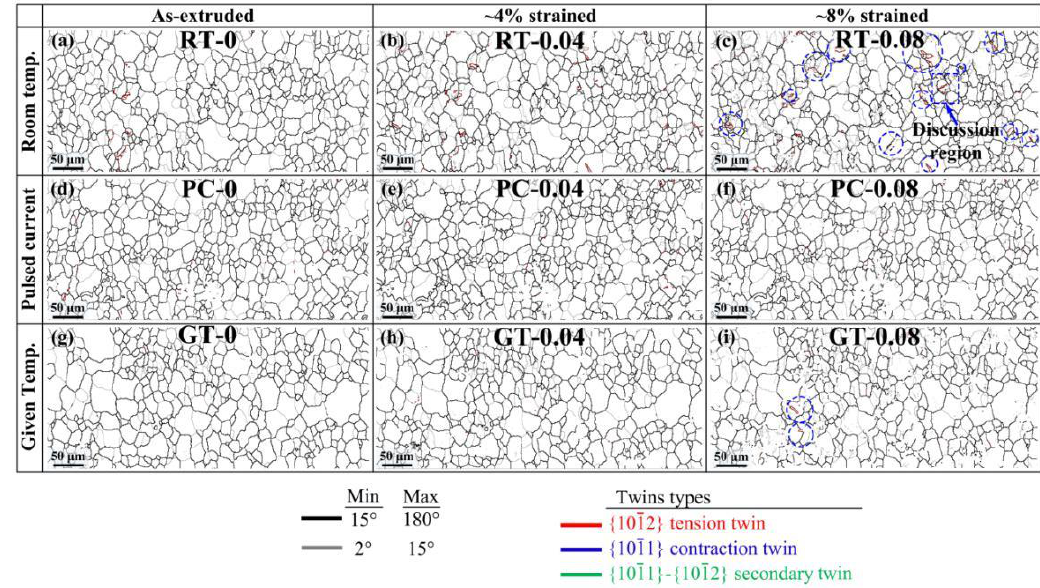
Figure 6. Boundary maps of ( a – c ) RT-0, RT-0.04 and RT-0.08; ( d – f ) PC-0, PC-0.04 and PC-0.08; ( g – i ) GT-0, GT-0.04 and GT-0.08 which correspond to each sub-map in Figure 4.